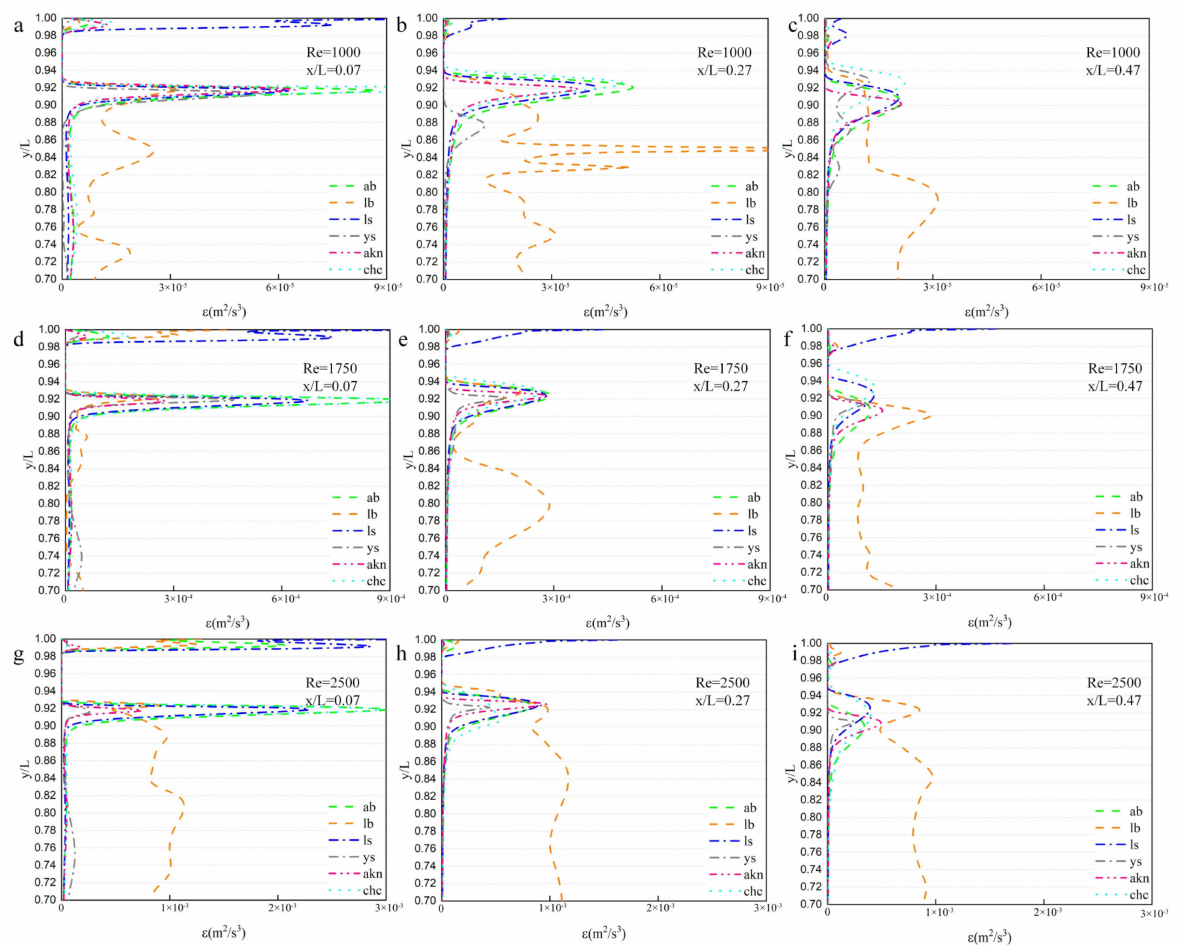
Figure 7. Comparison of dissipation rate of turbulent kinetic energy profiles measured by PIV and modeled by six low-Reynolds number k- ε models. ( a ) Re = 1000, x/L = 0.07; ( b ) Re = 1000, x/L = 0.27; ( c ) Re = 1000, x/L = 0.47; ( d ) Re = 1750, x/L = 0.07; ( e ) Re = 1750, x/L = 0.27; ( f ) Re = 1750, x/L = 0.47; ( g ) Re = 2500, x/L = 0.07; ( h ) Re = 2500, x/L = 0.27; ( i ) Re = 2500, x/L =